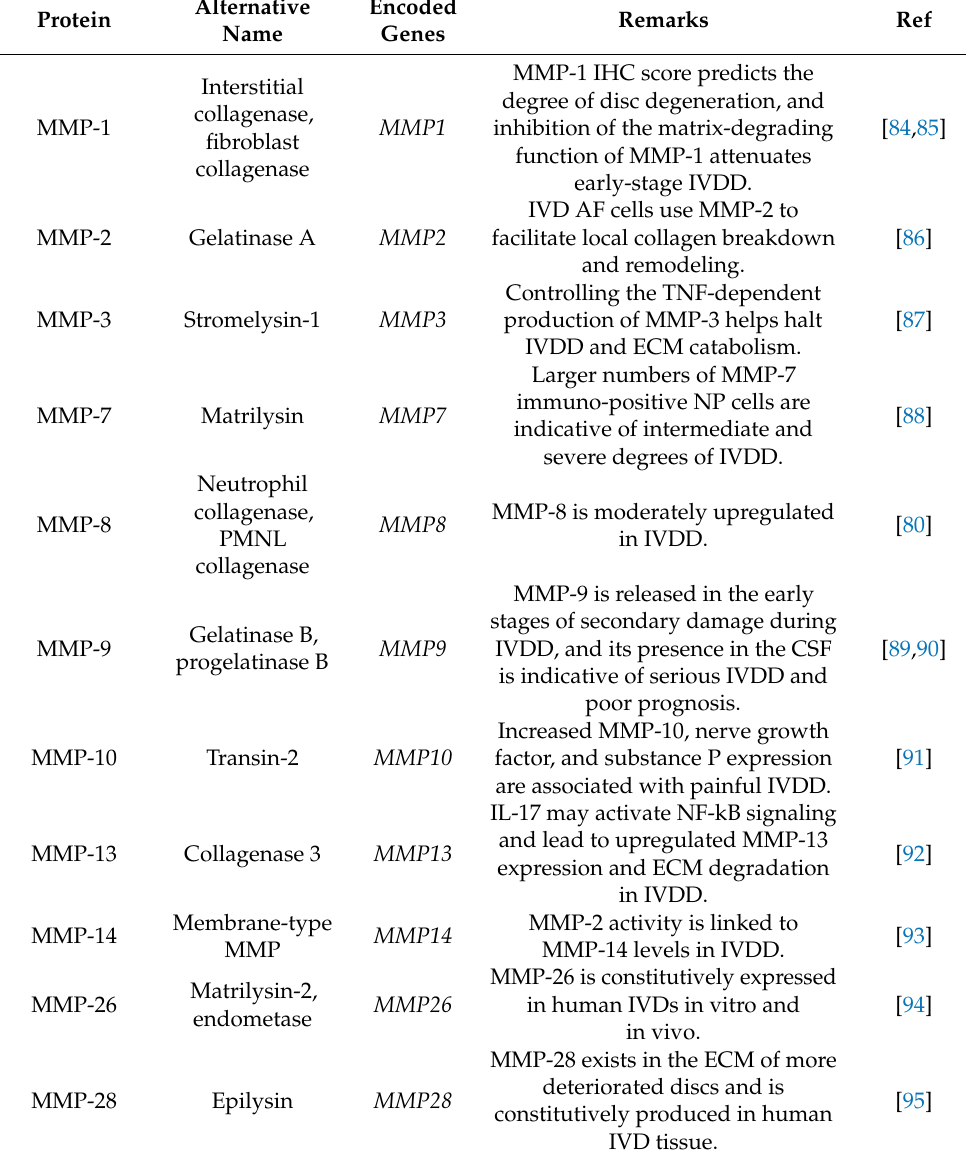
Table 2. Proteolytic MMP genes associated with ECM degradation in